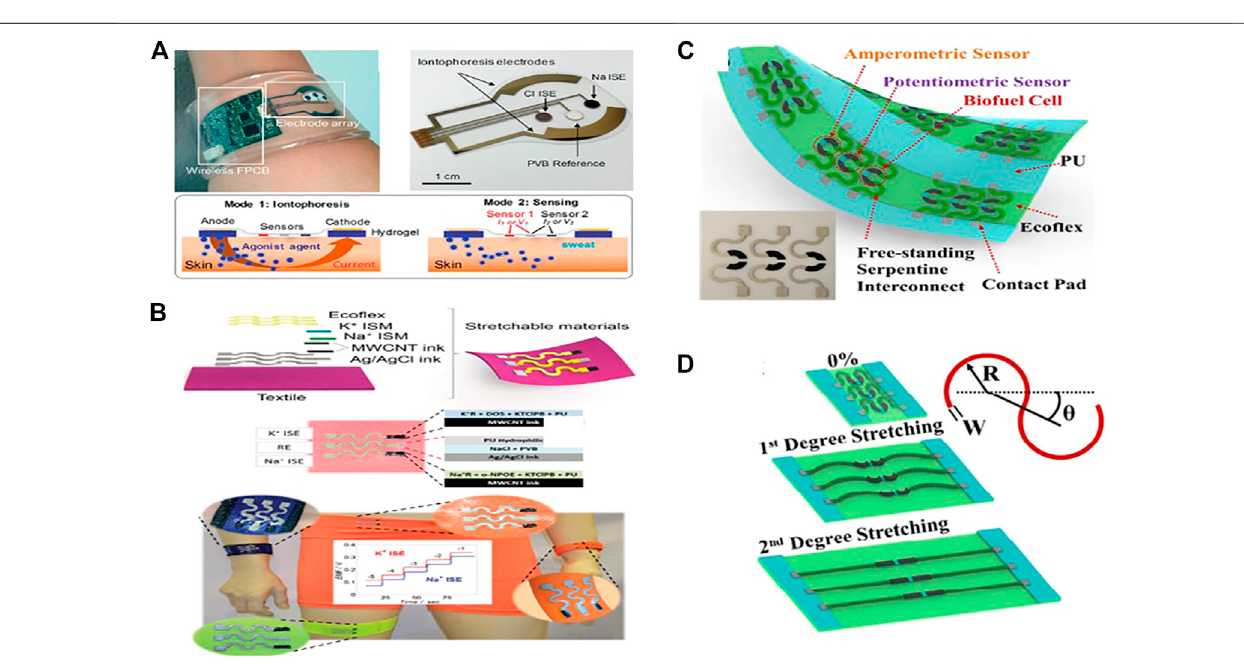
FIGURE 2 | Electrochemical biosensors that can be worn. (A) Image of an independent sweat extraction and sensor platform implanted on the skin, with a small layer of agonist agent hydrogel inserted under the iontophoresis electrodes (Copyright 2017; PNAS). (B) A wearable and stretchy CNT-based sensor printed on several standard textiles, as well as normal potassium and sodium measurement time trace graphs (Copyright 2016; Advanced Healthcare Materials). (C) all-in-one printed electrochemical biosensor and biofuel cell (BFC) arrays (copyright 2015, Nano Letters). (D) The two degrees of stretching allow printed arrays to withstand high strain levels (Copyright 2015; Nano